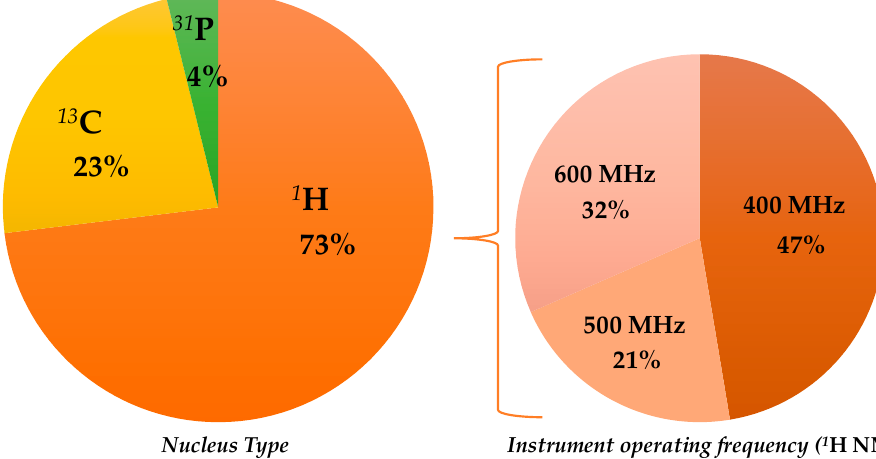
Figure 2. Graphical representation of the partition of selected nuclear magnetic resonance (NMR)- based studies on extra virgin olive oils (EVOOs)’ geographical origin assessment.